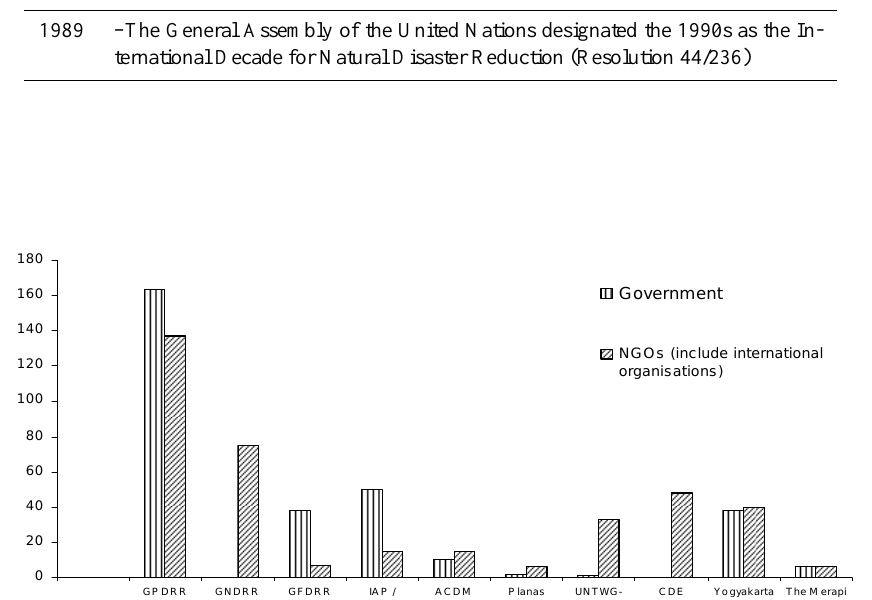
Figure 2: Number of government and NGO members in different MSPs (Source: calculated 347 Fig. 2. Number of government and NGO members in different MSPs (source: calculated from GPDRR, 2011a; GNDR, 2012a; GFDRR, from (Sourse: modified from GPDRR, 2011a; GNDR, 2012a; GFDRR, 2012g; ACDM, 2009; 348 2012g; ACDM, 2009; Planas PRB, 2009; UNTWG, 2006b; YLPDRR, 2011; UNDP Indonesia, Planas PRB, 2009; UNTWG, 2006b; YLPDRR, 2011; UNDP Indonesia, 2008). 349 350